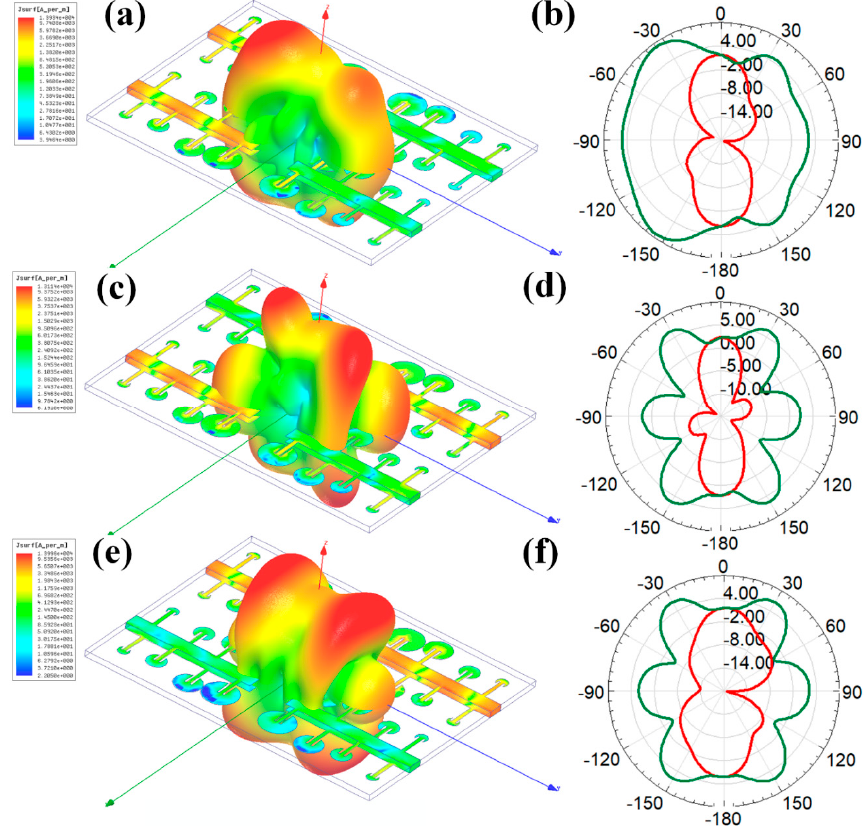
Figure 8. Variation in gain for the different modes of port excitation, along with co- and cross-polarization effects. Three-dimensional directivity with co- and cross-polarization for port excitation conditions of (P1, P2, P3, P4): ( a ) (0, 0, 1, 1), ( c ) (1, 0, 0, 1), and ( e ) (1, 0, 1, 0). Two-dimensional directivity with co- and cross-polarization for port excitation conditions of (P1, P2, P3, P4): ( b ) (0, 0, 1, 1), ( d ) (1, 0, 0, 1), and ( f ) (1, 0, 1, 0). co- (green line) and cross-polarization (red